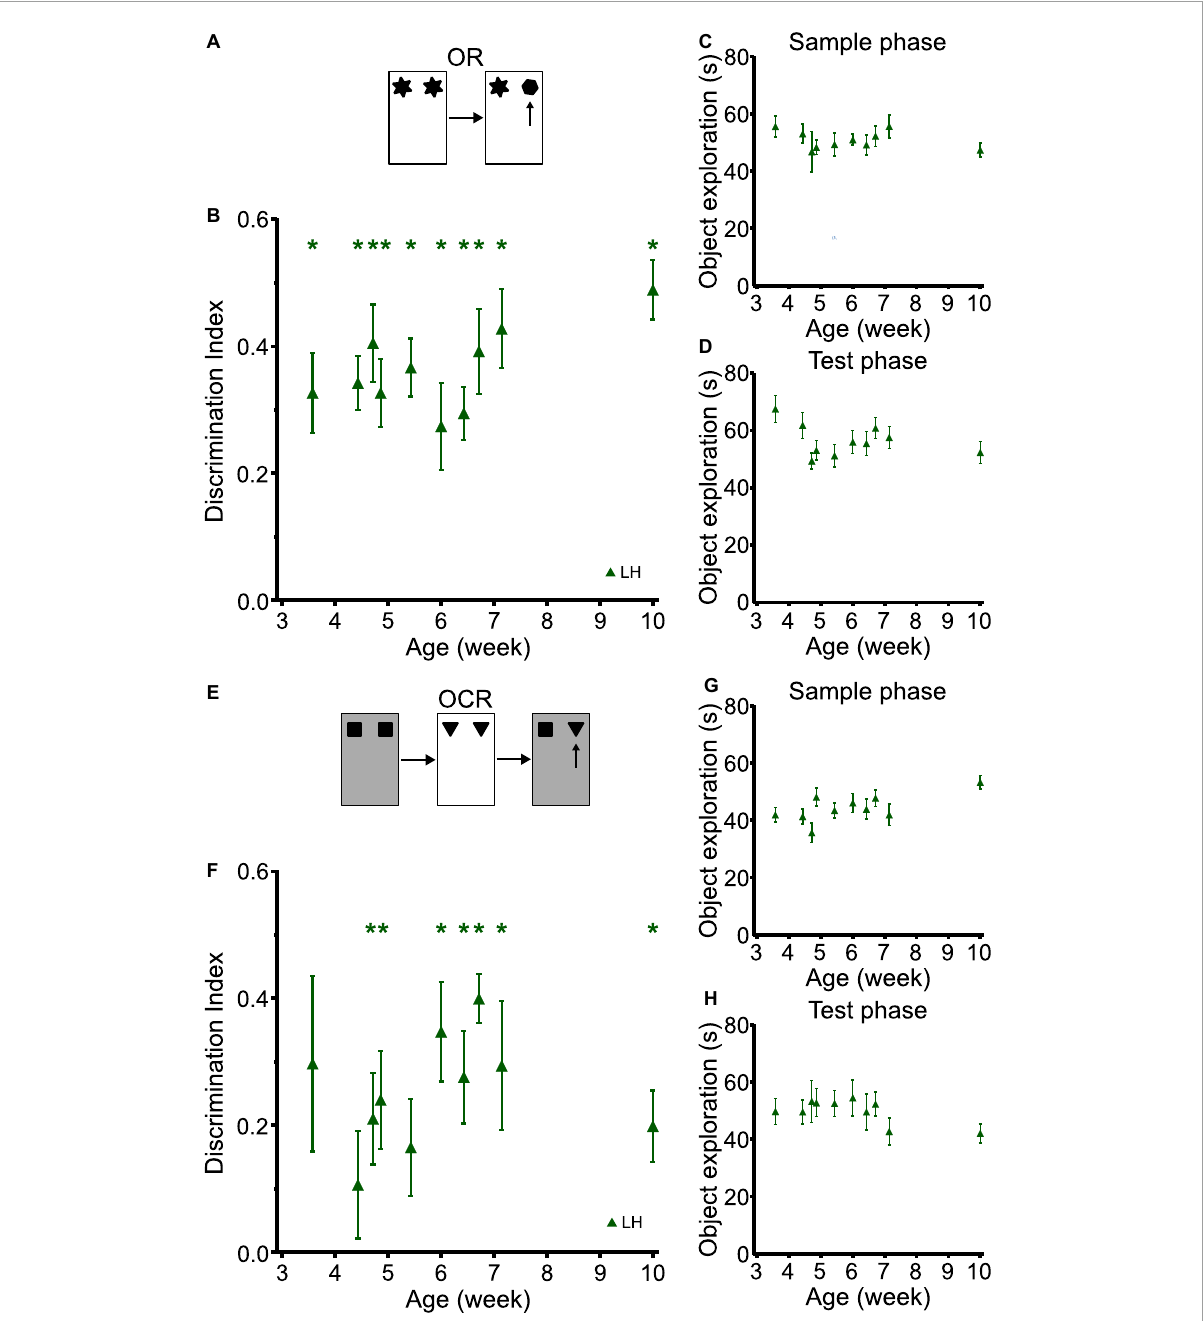
FIGURE6 LH rats tested in a cross-sectional study design exhibit similar developmental trajectories for object and object-context memory to LEH and SD rats. (A) Schematic of object recognition task; (B) Object recognition memory performance, expressed as discrimination index, for different cohorts of rats tested at different ages. Green asterisks indicate significant difference from chance (DI = 0), based on one-sample t -tests. LH rats show significant object recognition memory from the first time tested (P25) * p < 0.05. No significant effect of age was detected; (C) Object exploration during sample phase. No significant effect of age was detected; (D) Object exploration during test phase. No significant effect of age was detected; (E) Schematic of object-context recognition task; (F) Discrimination indices for object-context recognition task. LH rats show significant object-context recognition memory from P33 onwards, except at P42; (G) Object exploration during the sample phases of the OCR task (mean of the two sample phases). A significant main effect of age was detected; (H) Object exploration during test phase of the OCR task. There were no significant differences across age. [OR]: P25 (n ( females ) = 8, n ( males ) = 10), P31 (n ( females ) = 13, n ( males ) = 14), P33 (n ( females ) = 4, n ( males ) = 4), P34 (n ( females ) = 6, n ( males ) = 10), P38 (n ( females ) = 6, n ( males ) = 9), P42 (n ( females ) = 8, n ( males ) = 8), P45 (n ( females ) = 8, n ( males ) = 9), P47 (n ( females ) = 7, n ( males ) = 9), P50 (n ( females ) = 7, n ( males ) = 8), P70 (n ( females ) = 8, n ( males ) = 8); [OCR]: P25 (n ( females ) = 8, n ( males ) = 8), P31 (n ( females ) = 11, n ( males ) = 13), P33 (n ( females ) = 4, n ( males ) = 4), P34 (n ( females ) = 6, n ( males ) = 9), P38 (n ( females ) = 5, n ( males ) = 9), P42 (n ( females ) = 8, n ( males ) = 8), P45 (n ( females ) = 8, n ( males ) = 9), P47 (n ( females ) = 7, n ( males ) = 7), P50 (n ( females ) = 7, n ( males ) = 8), P70 (n ( females ) = 8, n ( males ) = 8). For details on sample sizes, t , and p -values for one-sample t -tests, see Supplementary Table 2